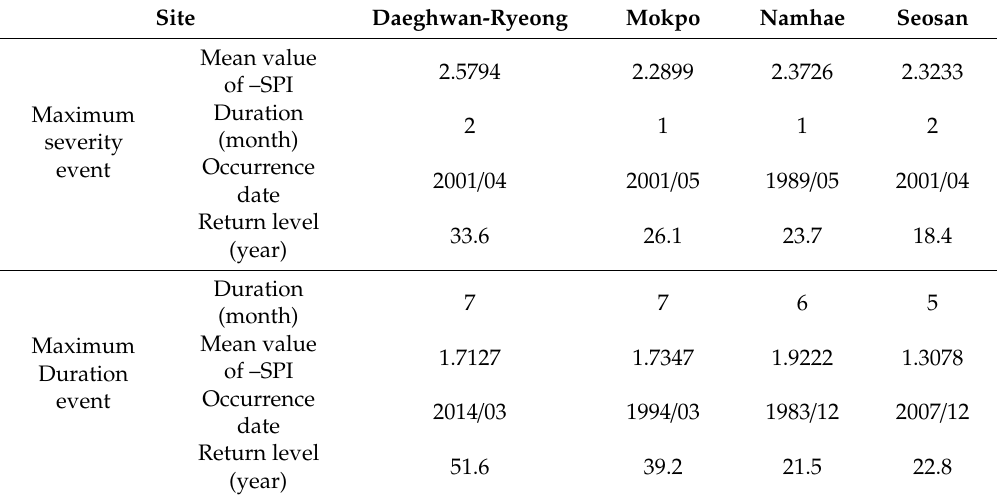
Table 4. Most extreme drought